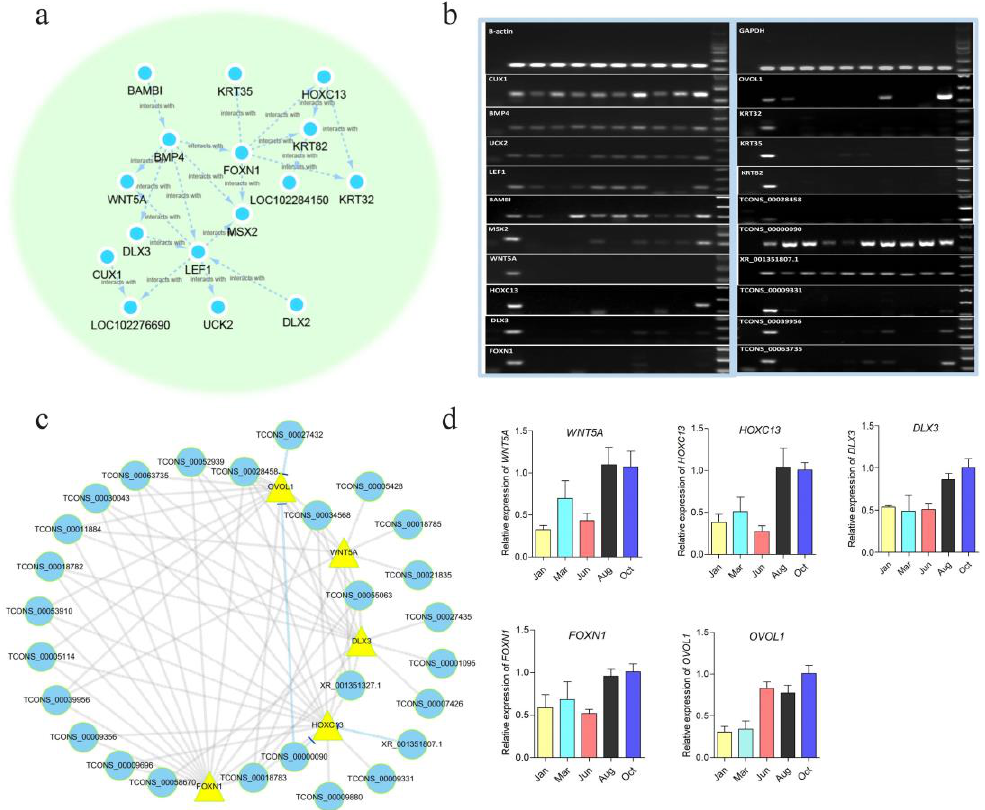
Figure 4. Analysis of PPI and expression characteristics of the hub genes in the blue module. ( a ) A subnetwork of PPI analysis result for the top 100 genes in the blue module. ( b ) PCR detected the tissue specific of a part of hub genes in the blue module network. The lanes from left to right represent the negative control, skin, small intestine, heart, liver, spleen, lungs, kidney, fat, muscle, testis, and 2000 Marker. ( c ) The interaction network of five mRNAs that specifically expressed in skin with its associated lncRNAs, which was analyzed by the Pearson correlation coefficient (Pearson correlation ≥0.90 or ≤0.90) and visualized by Cytoscape. The circles in blue represent lncRNAs and the triangles in yellow represent the mRNAs. The lines in blue and the arrows indicate negative effect, and others represent positive regulation. ( d ) RT-qPCR results for WNT5A , HOXC13 , DLX3 , FOXN1 , and OVOL1 during the HFs cycle of yak.